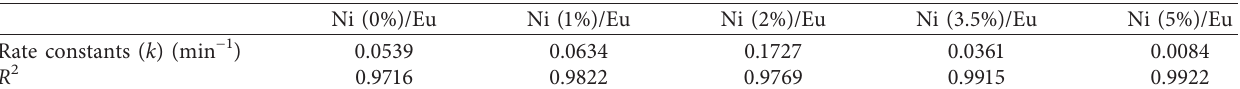
Table 6: Kinetic parameters of 20mg · L − 1 RhB in electrochemical processes by Ti/SnO